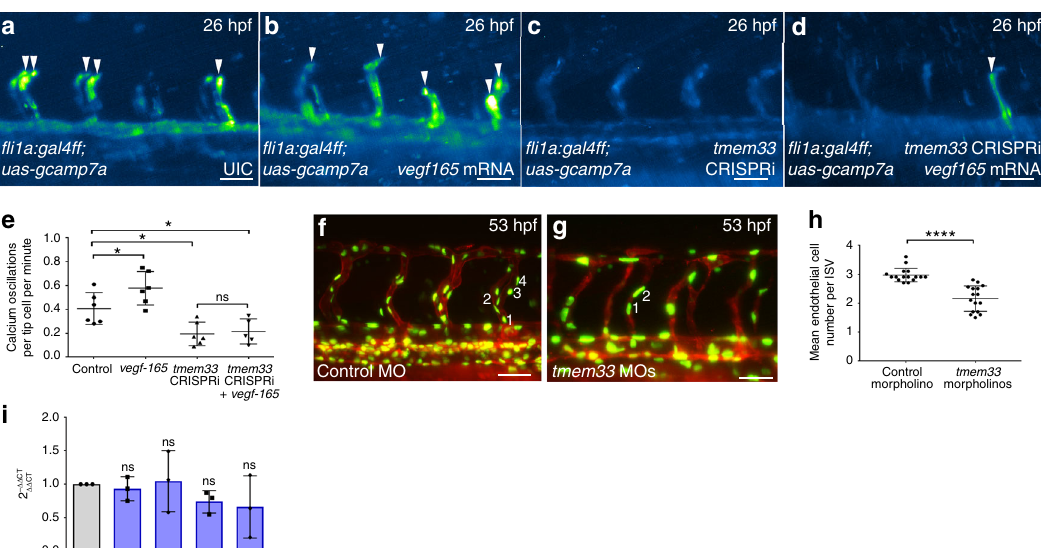
Fig. 4 tmem33 functions downstream of Vegfa during angiogenesis. a – e tmem33 knockdown prevents Vegfa-mediated increases in Ca 2 + oscillations. Overexpression of vegfa 165 signi fi cantly increases frequency of Ca 2 + oscillations in SeAs, whereas tmem33 knockdown alone and in the presence of vegfa 165 signi fi cantly reduce frequency of Ca 2 + oscillations in SeAs. Intensity projection over time showing Ca 2 + oscillations highlighting intensity change over duration of time lapse. Embryos display changes in fl uorescence in SeA tip cells (white arrowheads) (two-way ANOVA with Holm – Sidak ’ s corrections: * p = < 0.05. 2 Repeats, n = 3 embryos per group) (scale bars 50 µ m). f – h tmem33 knockdown using 0.4 ng morpholinos reduces EC number in ISVs at 53 hpf. h Unpaired t -test; **** p < 0.0001; t = 6.507; df = 30; 2 repeats; n = 8 embryos per group. i VEGF receptor expression is not signi fi cantly affected in tmem33 crispants (one-way ANOVA with Dunnett ’ s corrections; p = < 0.05, n = 3 repeats). Source data are provided as a Source Data fi